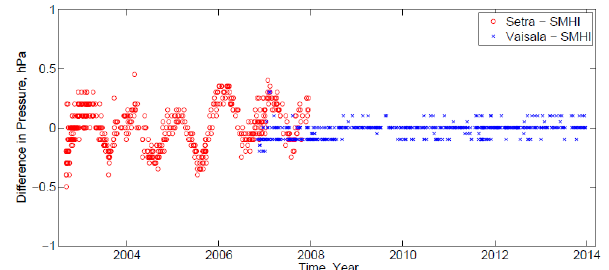
Figure 7. Differences in the surface pressure measured by three dif- ferent